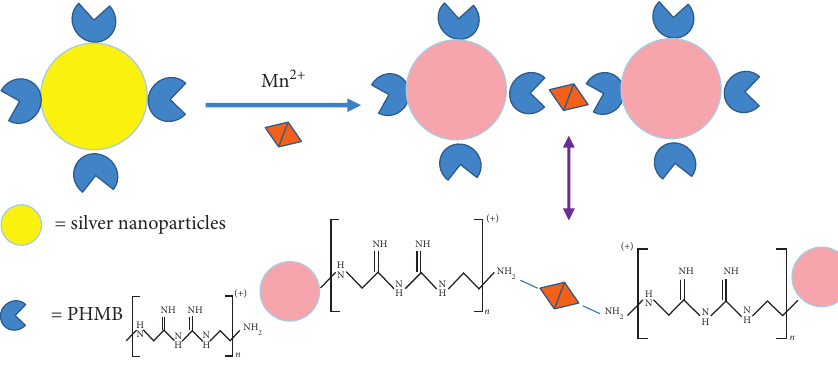
Figure 7: Mechanism of Mn 2+ -induced AgNPs/PHMB aggregation.